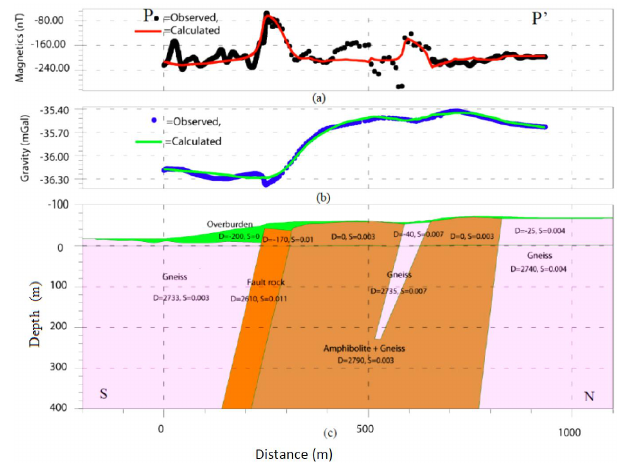
Fig. 7. 2-D model along profile PP 0 . Density ( D ) and suscepti- bility ( S ) of the blocks are in SI units. See text for modelling de- tails. Note that for modelling Bouguer gravity anomalies, density contrasts with respect to the reduction density are used above the reduction level (i.e.